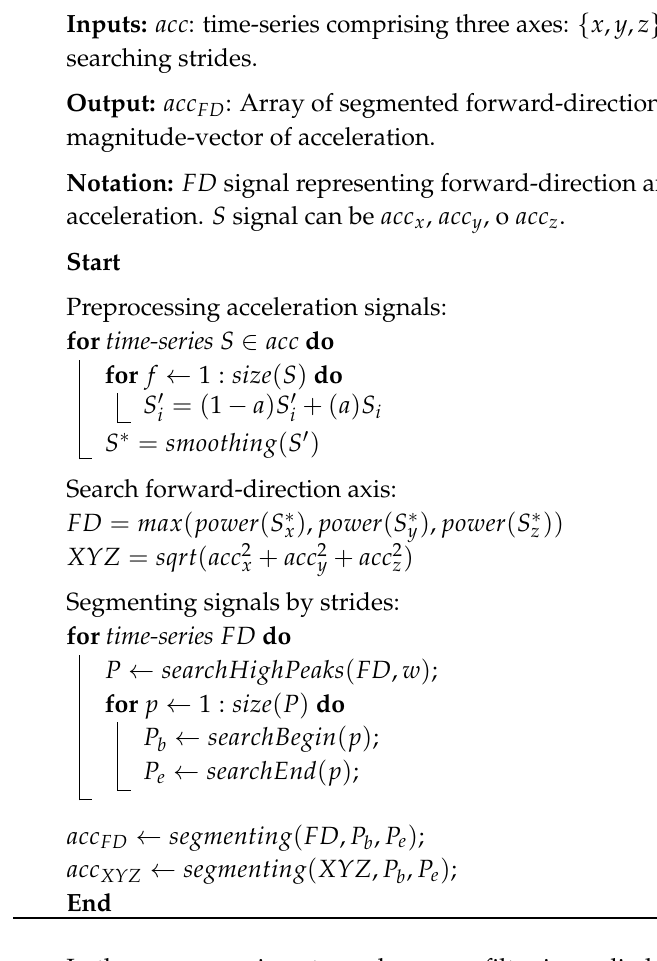
Algorithm 1: Summary of the strides segmentation